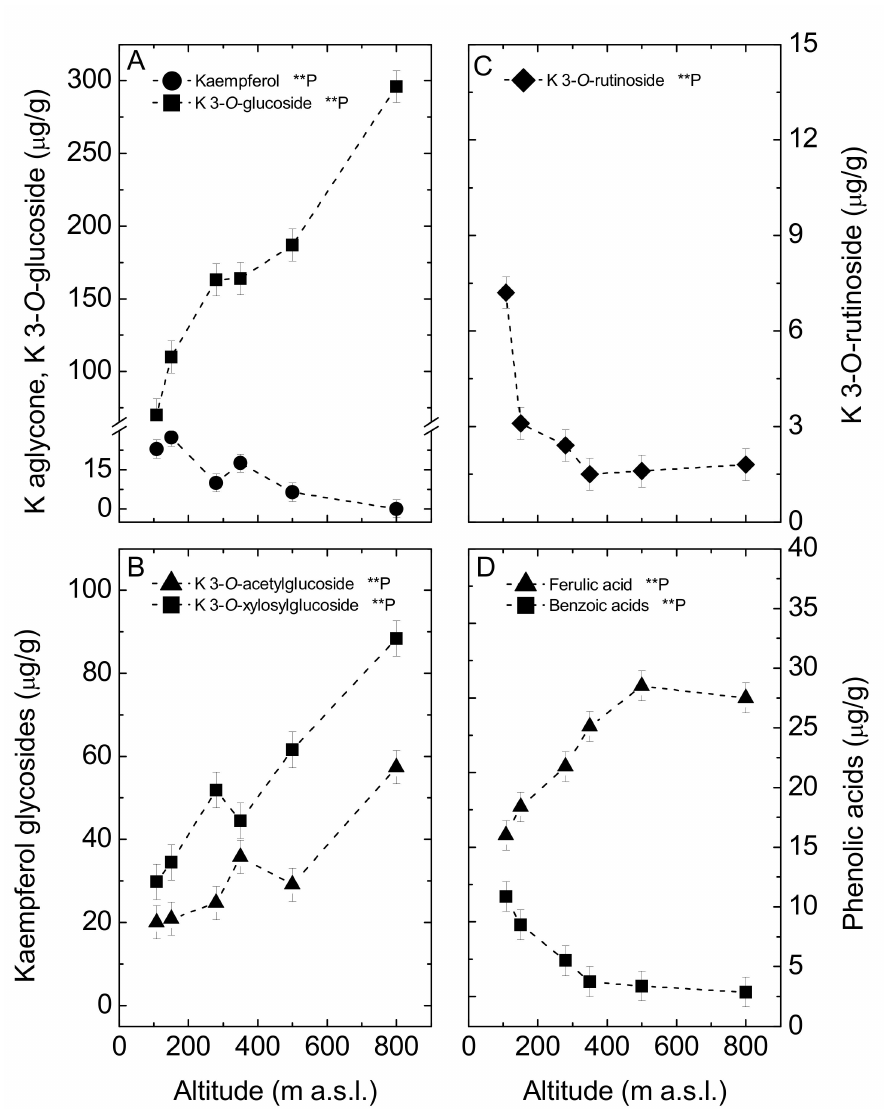
Figure 1. Altitudinal variation in the levels of ( A ) kaempferol aglycone and kaempferol 3- O -glucoside, ( B ) kaempferol 3- O -diglucoside and kaempferol 3- O acetylglucoside, ( C ) kaempferol 3- O -rutinoside, and ( D ) ferulic acid and benzoic acids in “Zolfino del Pratomagno”. Superscripts were significant at ** p < 0.01. For each altitude, n =